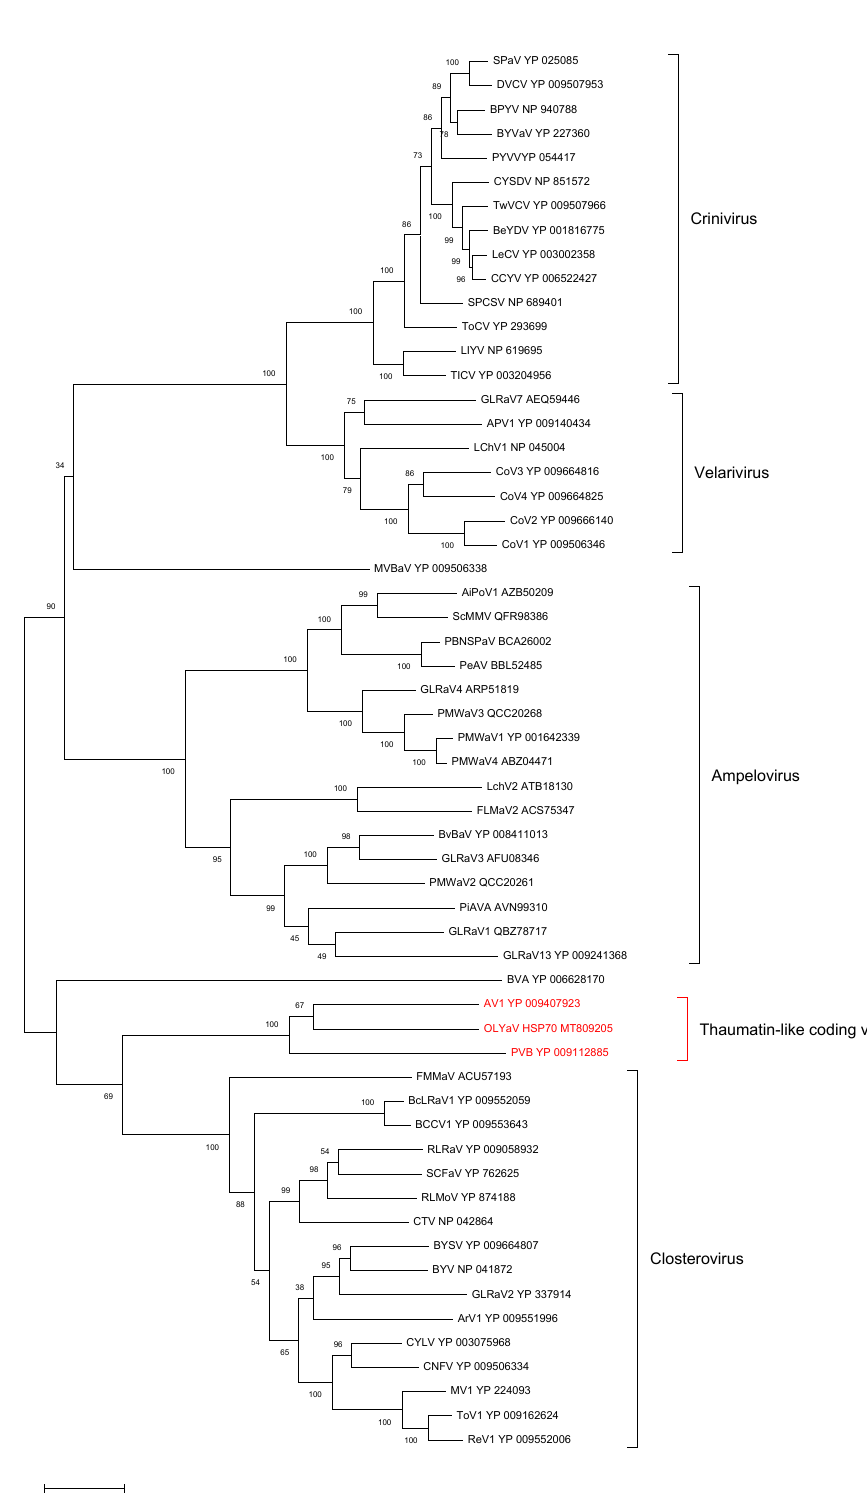
Figure 8. Maximum likelihood phylogenetic tree using the best substitution model by MEGA X of HSP70h from representative members of the family Closteroviridae . Proteins of the isolates are identified by their protein_id number. The scale bar shows the genetic distance. Bootstrap percentages (500 re-samples) are indicated on the branches.